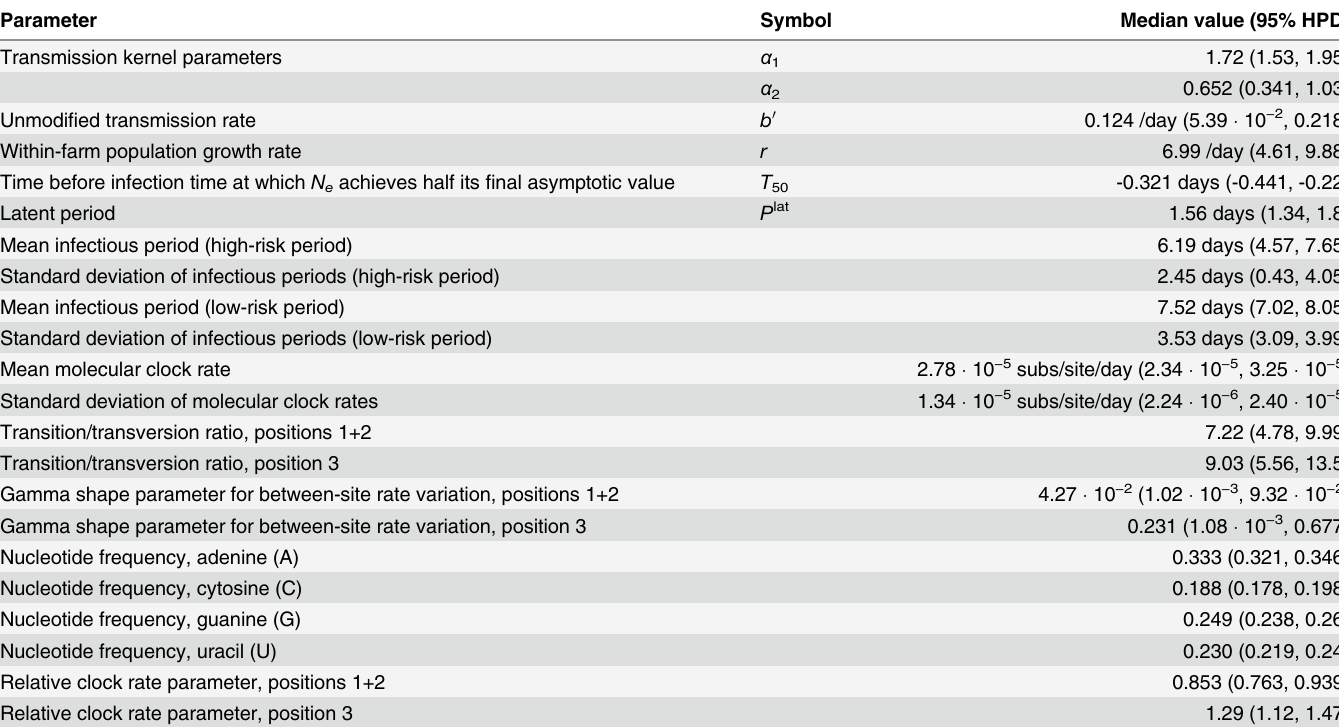
Table 6. Estimates of parameters from the H7N7 outbreak, posterior median and 95% HPD